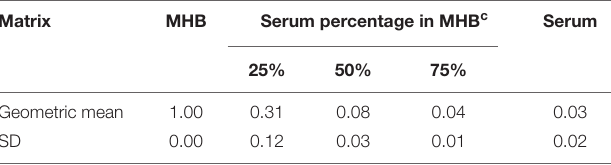
TABLE 3 | Tulathromycin MICs (mg/L) for S. suis ATCC 43765 in MHB and 25, 50, 75, and 100% porcine serum. a ,